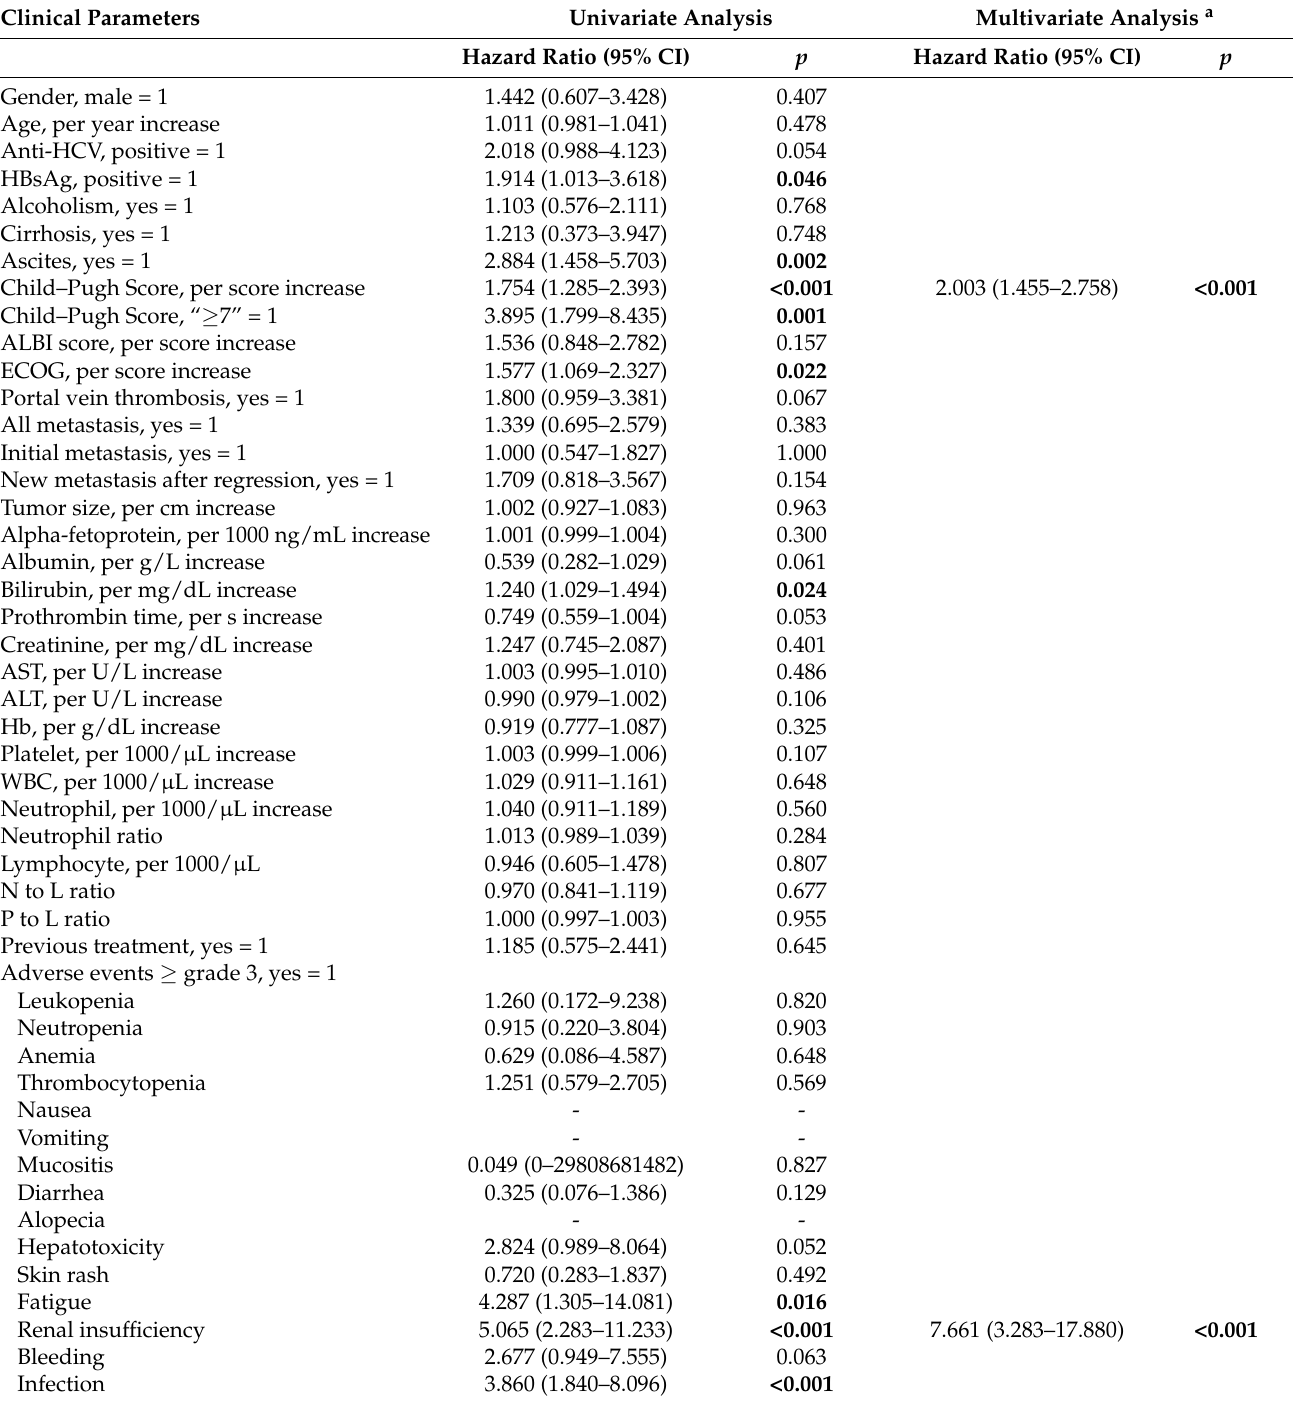
Table 2. Cox proportional hazard analysis for association between clinical factors and overall survival